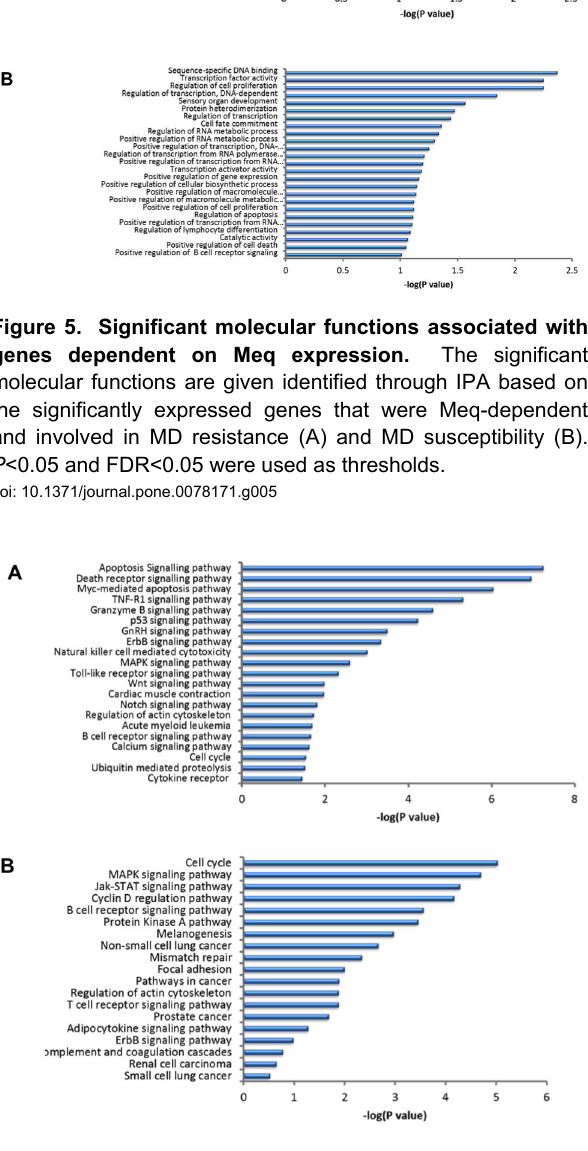
Figure 6. Significant pathways associated with genes dependent on Meq expression. IPA pathway analysis for significantly expressed genes that are Meq-dependent and involved in MD resistance (A) and MD susceptibility (B). P <0.05 and FDR<0.05 were used as thresholds to select significant canonical